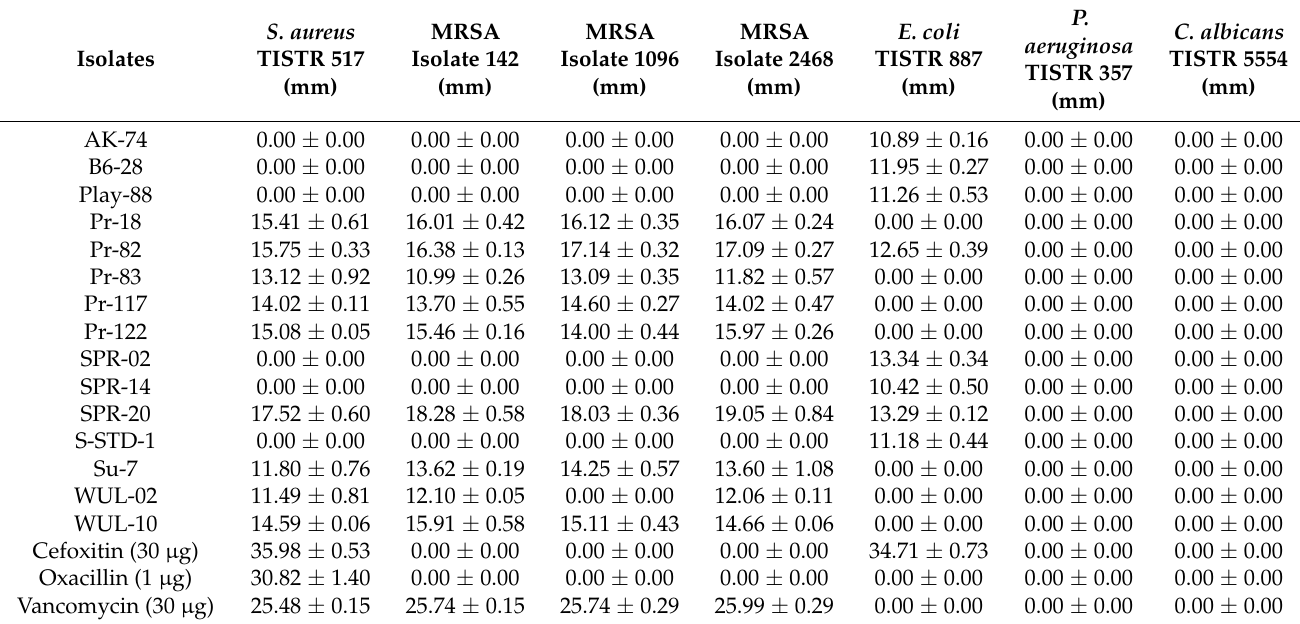
Table 2. Agar well diffusion assay of the active isolates against human pathogens (means ± SD; n = 3).